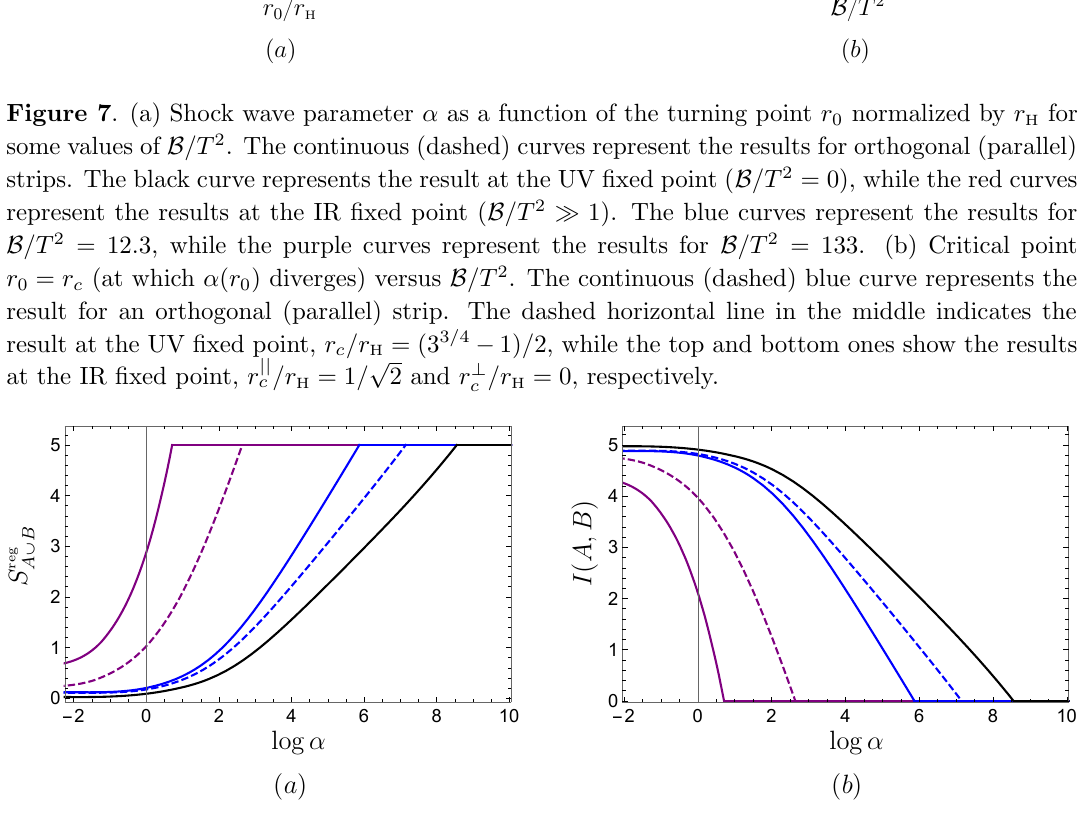
Figure 8 . (a) Regularized entanglement entropy S reg (in units of V 2 =G ) as a function of log (cid:11) . N A [ B (b) Mutual information I ( A; B ) (in units of V 2 =G N ) as a function of log (cid:11) . All the curves have the same mutual information I ( A; B ; 0) = 5 at (cid:11) = 0. In both (a) and (b) the curves correspond (from right to left) to =T 2 = 0 (black curves), =T 2 = 12 : 3 (blue curves), =T 2 = 133 (purple B B B